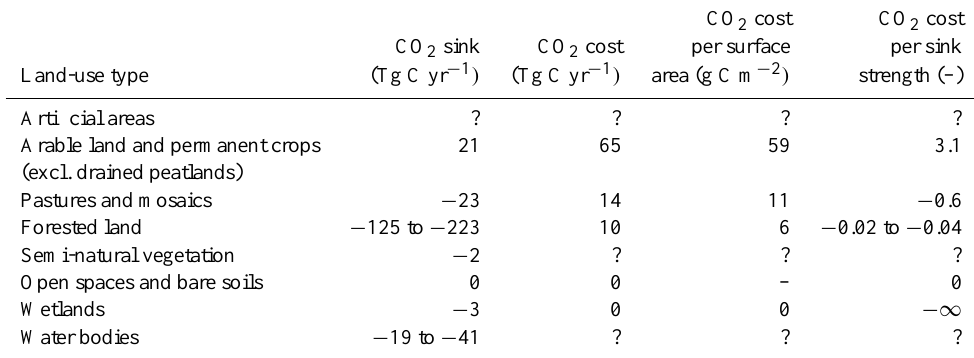
Table 5. CO 2 cost of land management in Europe based on life cycle analysis. The inventory-based sink was used to estimate the CO 2 cost per unit sink